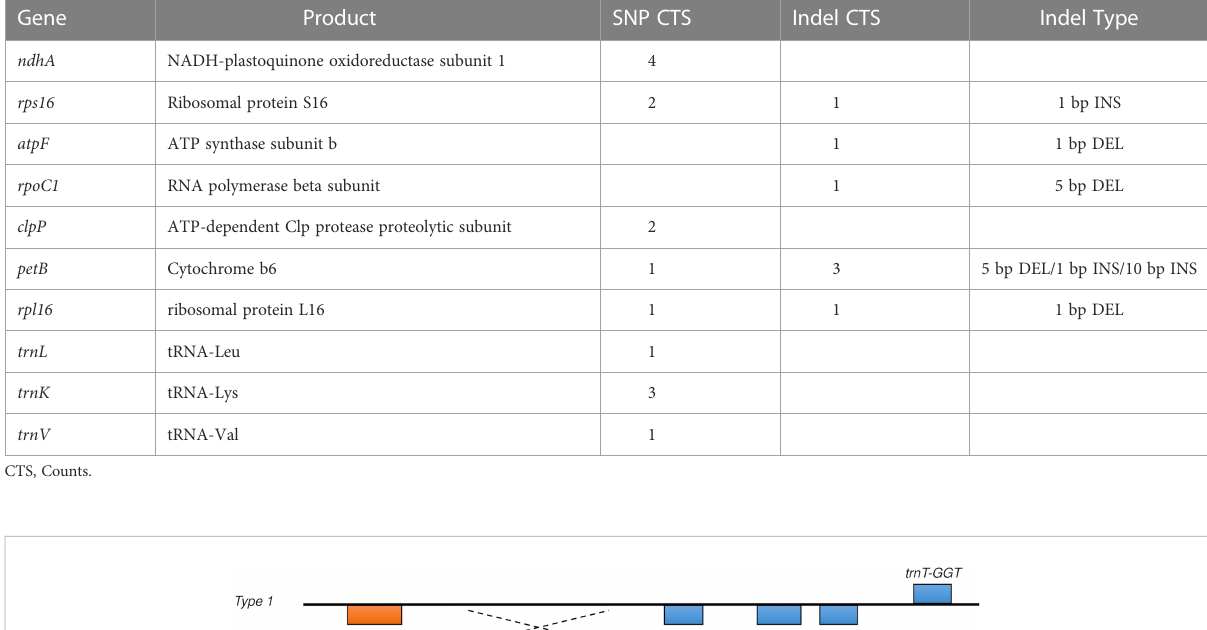
TABLE 4 Number of variations found in introns of T. esculentum chloroplast genes.